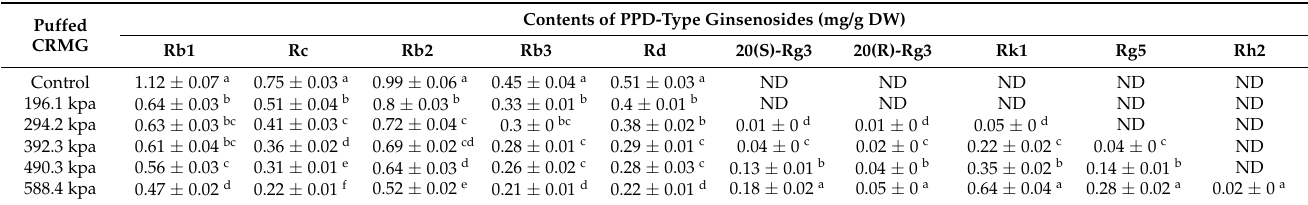
Contents of PPD-Type Ginsenosides (mg/g DW)